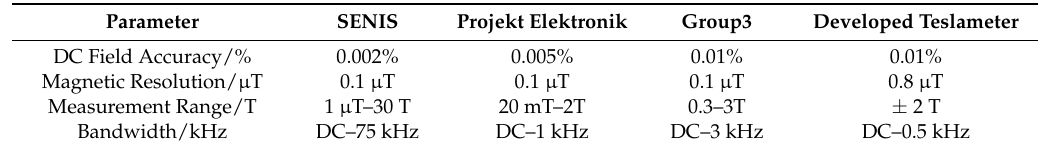
Table 5. General specifications summary of state of the art teslameters currently found on the market in comparison to the developed instrument. Information adapted from